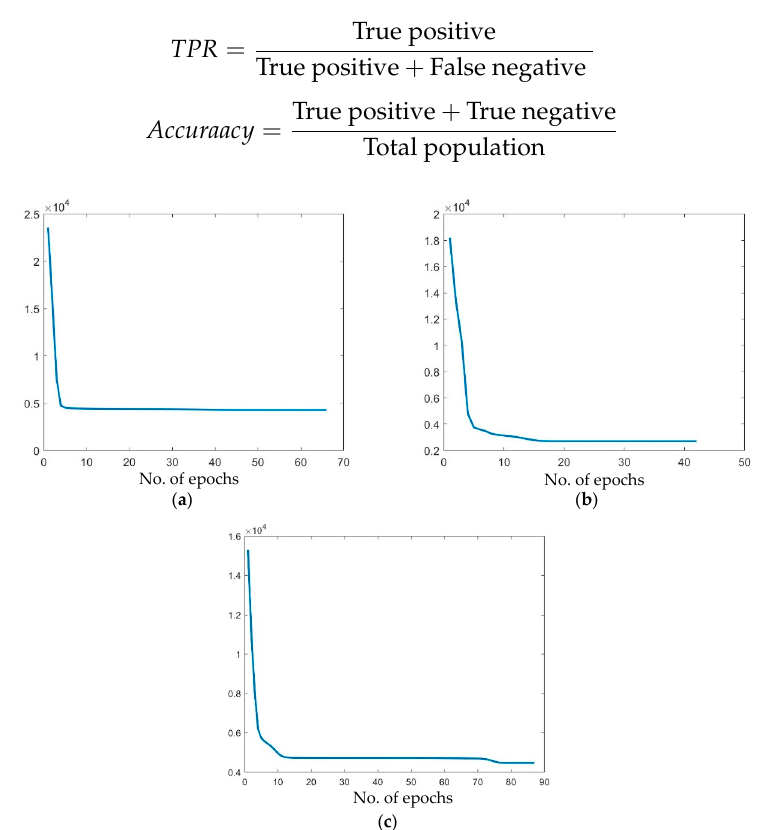
Figure 2. Illustration of the training error of fuzzy clustering in patent infringement datasets. ( a ) c = 3; ( b ) c = 4; ( c ) c = 5.